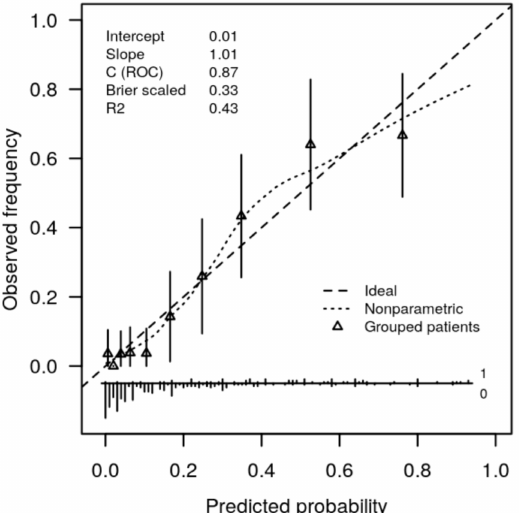
Figure 2. Validation plot for complete model. Correspondence between predicted probabilities and observed frequencies of current smoking in the studied participants, sub-grouped by deciles of predicted probability. Triangles and whiskers show average and 95% confidence intervals for observed frequencies of actual smoking in each subgroup (bottom). Spikes represent participant distribution according to individual predicted probability for smoking status (1 = smoker, 0 = nonsmoker).